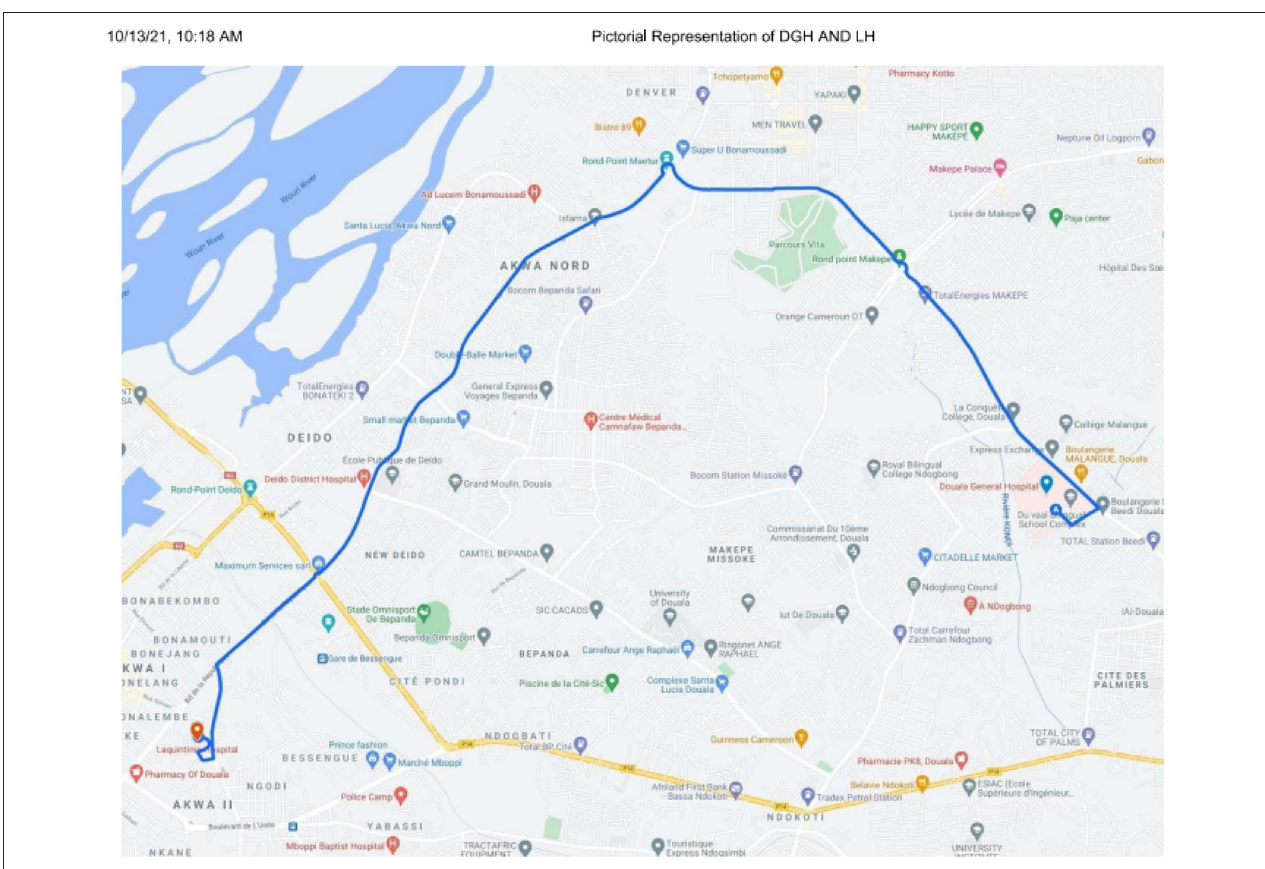
FIGURE 2 | Pictorial Representation of DGH and